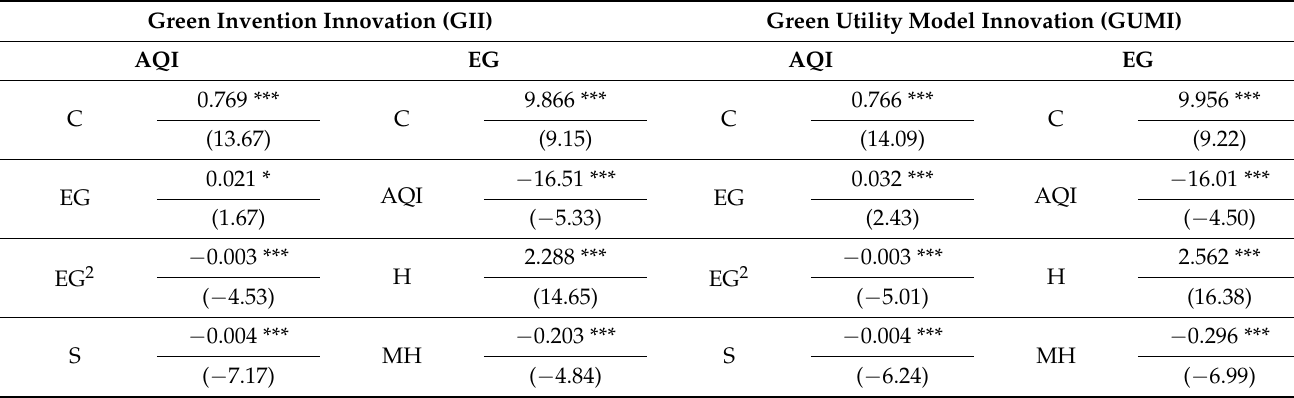
Table 8. Robustness test results of the impact of different types of GTI on SP and